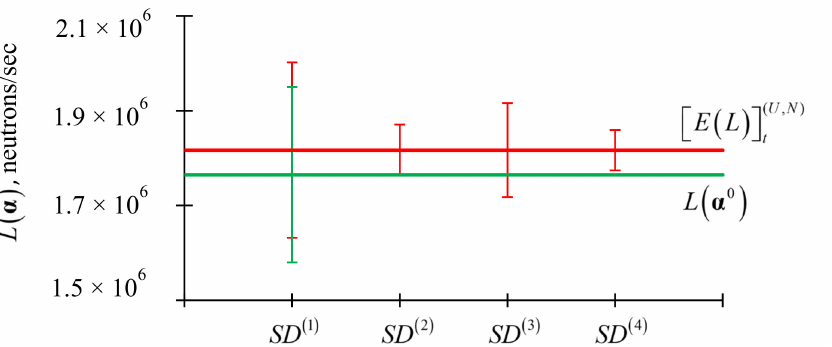
Figure 1. Comparison of L due to 1% standard deviations of the uncorrelated microscopic total cross sections.